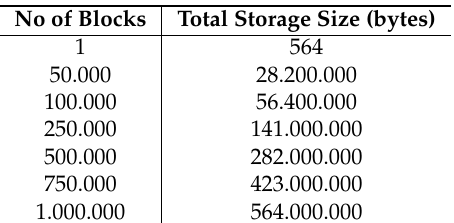
Table 4. Experimental results: Analysis of the blockchain storage size according to the number of blocks.